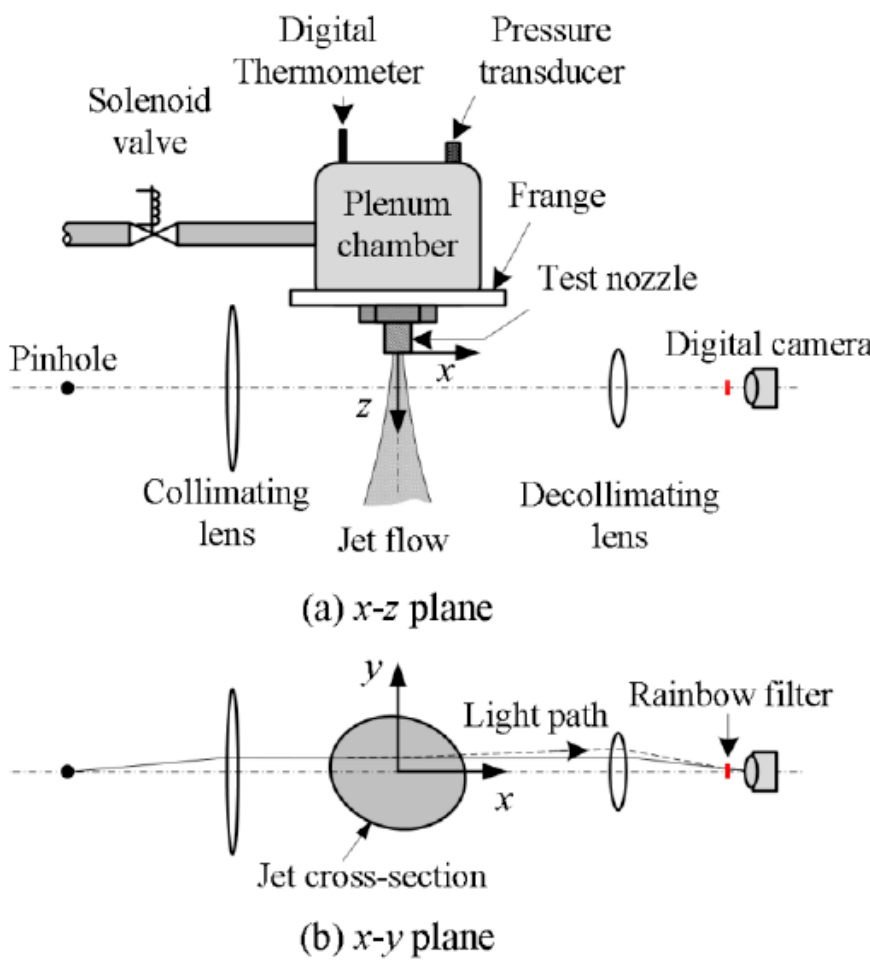
Figure 28. Experimental layout for rainbow Schlieren combined with computer tomography. Reprinted with permission from Ref. [45]